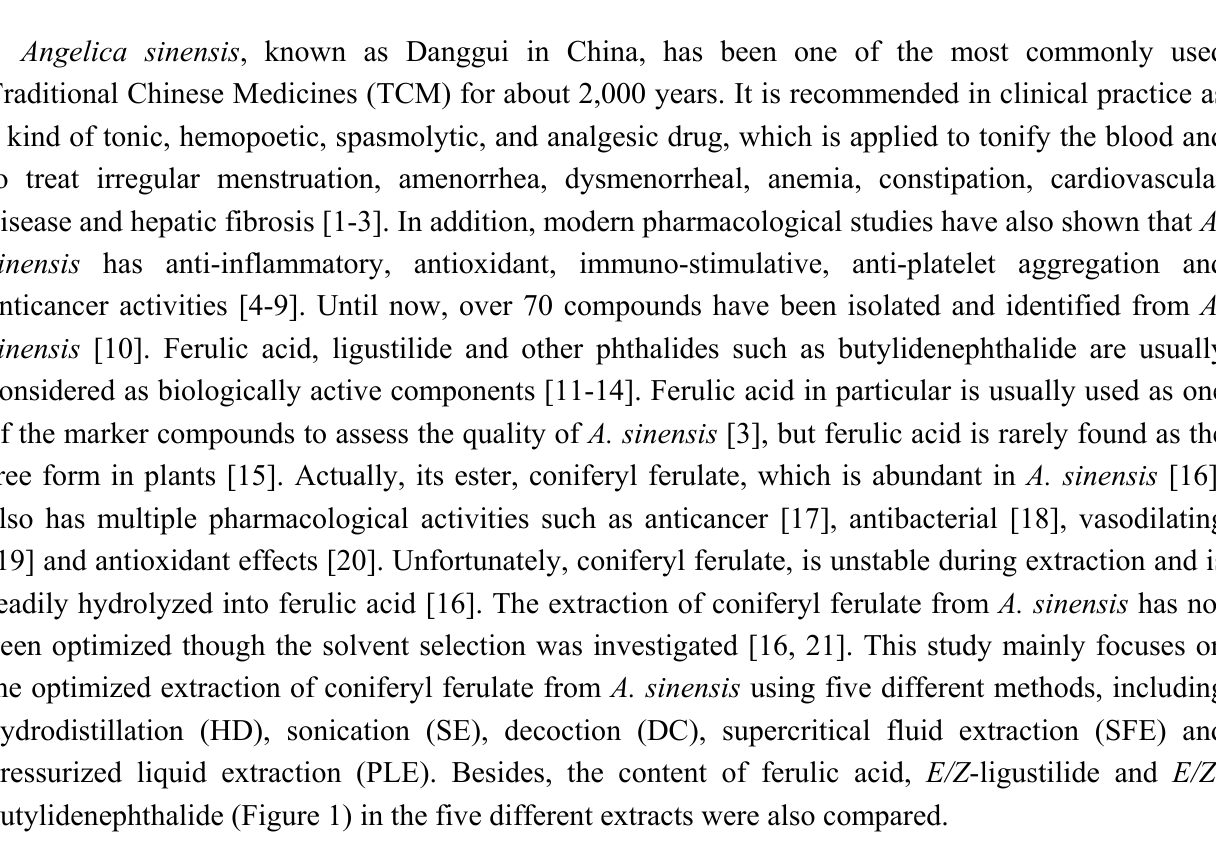
Figure 1. The structures of six investigated compounds in Angelica